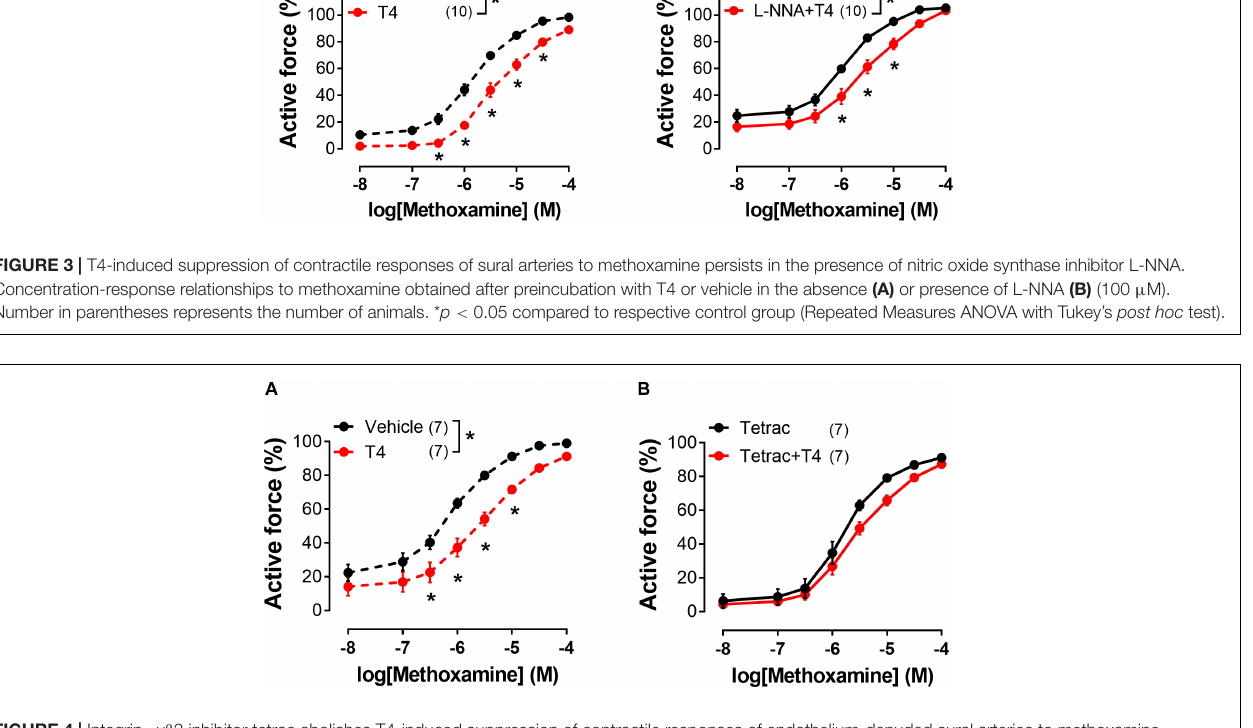
FIGURE 4 | Integrin α v β 3 inhibitor tetrac abolishes T4-induced suppression of contractile responses of endothelium-denuded sural arteries to methoxamine. Concentration-response relationships to methoxamine obtained after preincubation with T4 or vehicle in the absence (A) or presence (B) of tetrac (3 µ M). Number in parentheses represents the number of animals. * p < 0.05 compared to vehicle group (Repeated Measures ANOVA with Tukey’s post hoc